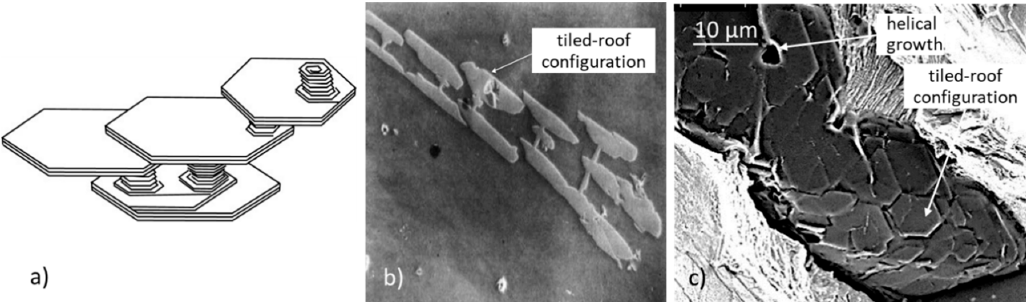
Figure 9. Foliated crystals in tiled-roof arrangement: ( a ) Schematic representation, reproduced from [42] with permission from Springer; ( b ) Al 3 Ti foliated dendrites with tiled roof configuration in Al-1.15 wt% Ti alloy; magnification ×40, reproduced from [44] with permission from Elsevier; ( c ) fracture area in fatigue fractured lamellar graphite iron; compliments of W.L. Guesser and the Tupy/SENAI project, reproduced from [30] with permission from Elsevier.